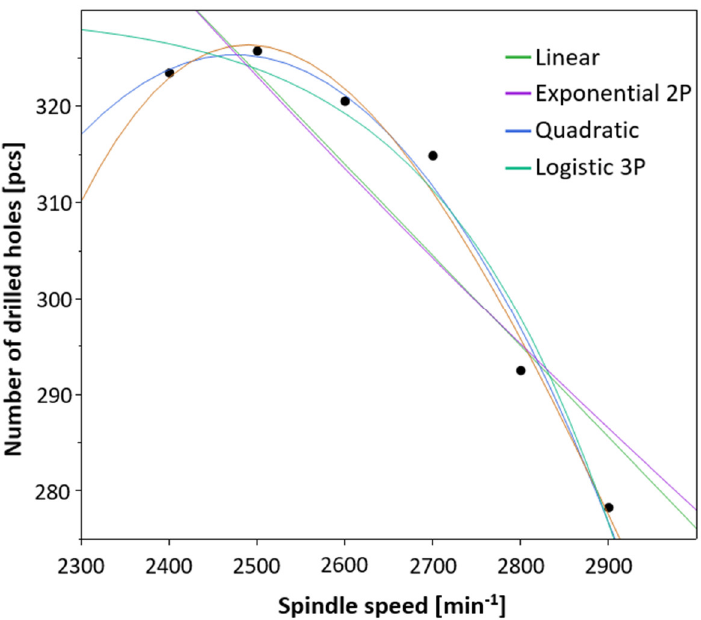
Figure 12. Plotted representation of individual models examining the dependence of the number of the holes drilled up to the moment of tool damage on speed change.